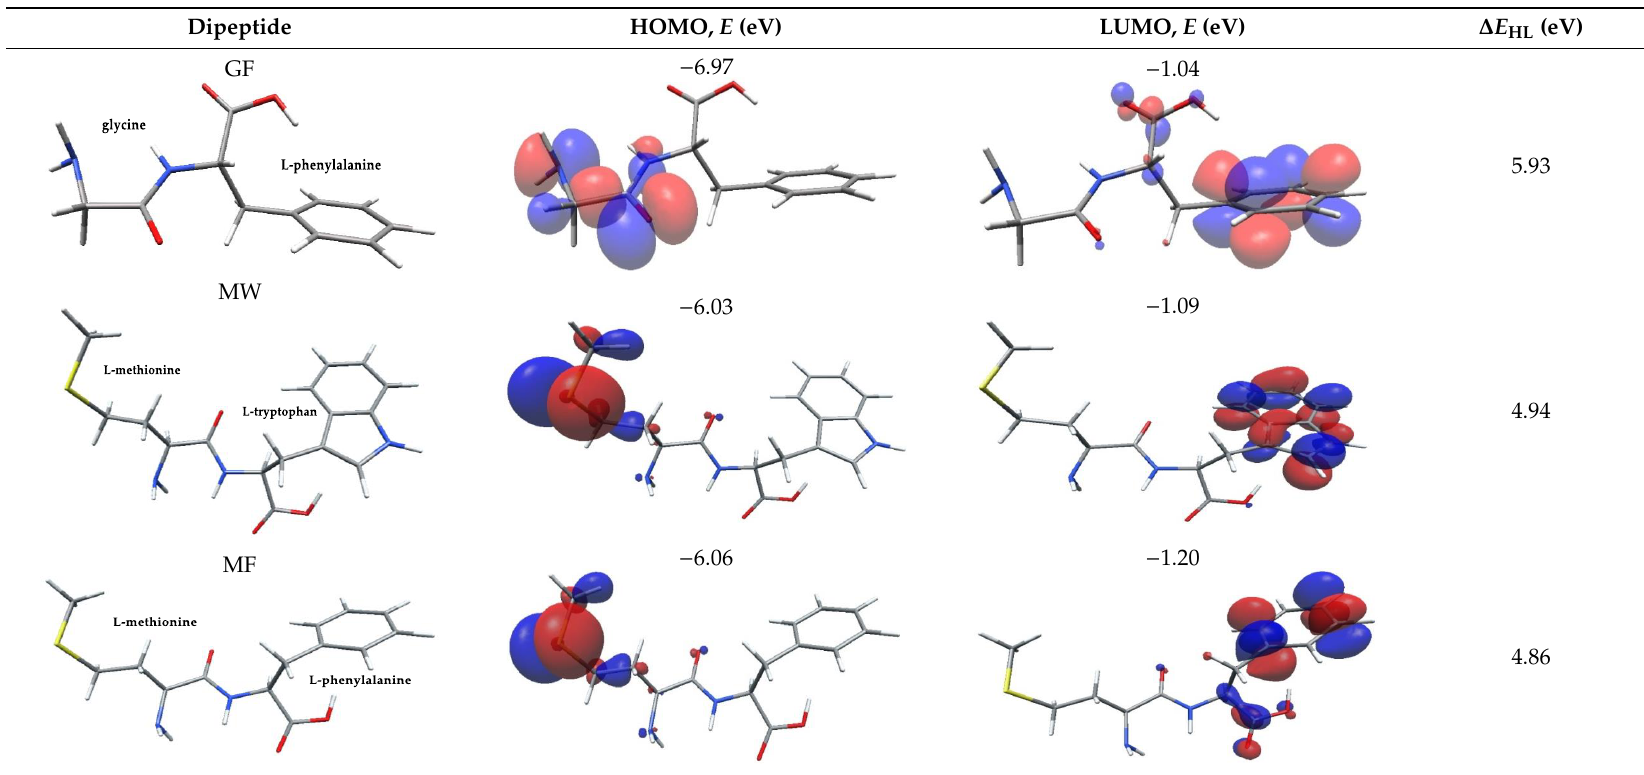
Table 6. Highest occupied and lowest unoccupied molecular orbitals (HOMO and LUMO), their orbital energies, as well as the HOMO–LUMO energy gap for selected peptides from Sus scrofa .